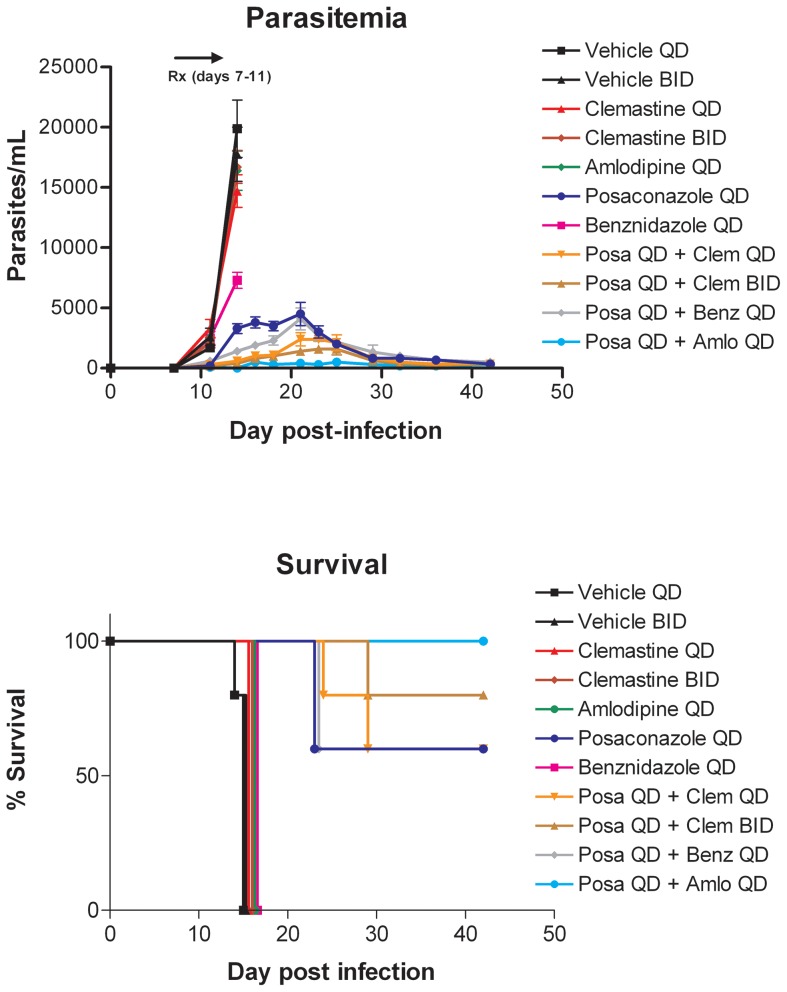
Murine efficacy study #2.As in figure 2.